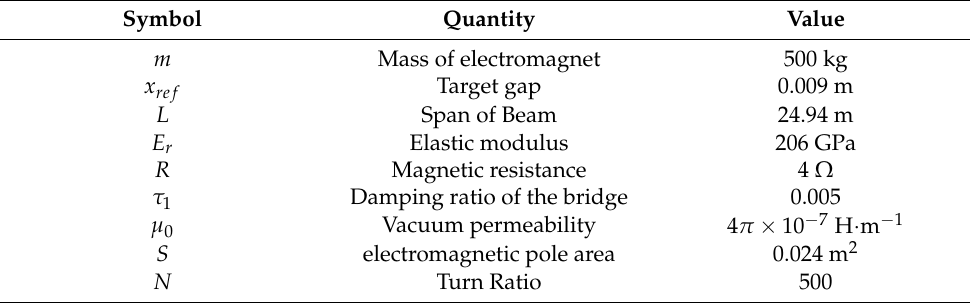
Table 1. Physical parameters value of a maglev coupled vehicle-bridge system. Symbol